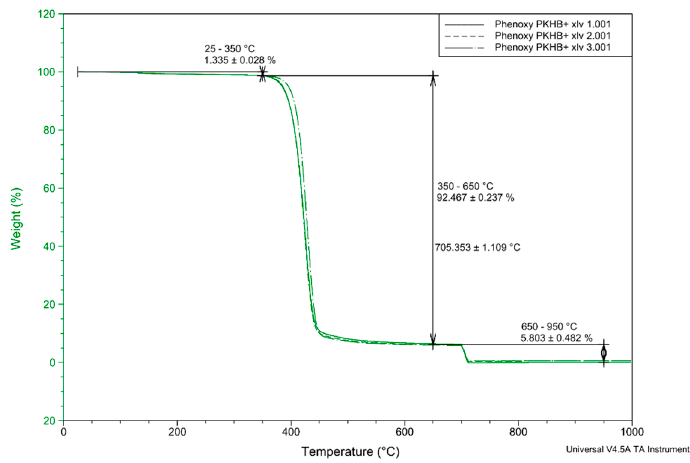
Figure 3. Thermogravimetric analysis (TGA) characterization for